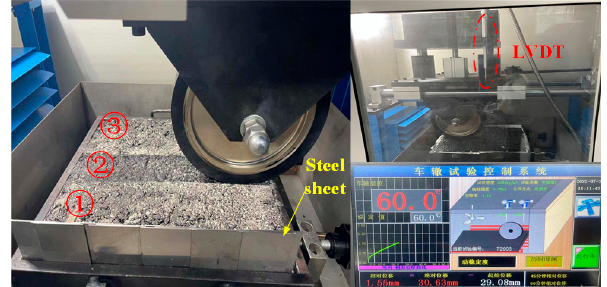
Figure 2. Rutting